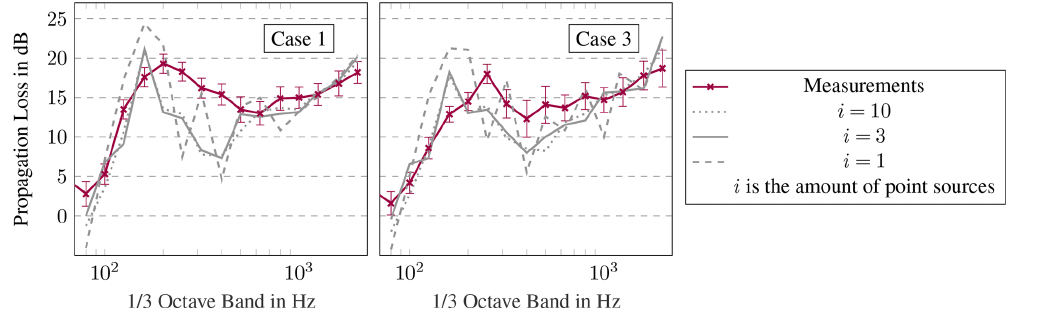
Figure 12. Comparison of measured and modelled sound propagation losses between 178 and 845m with different numbers of sound sources i per one-third octave